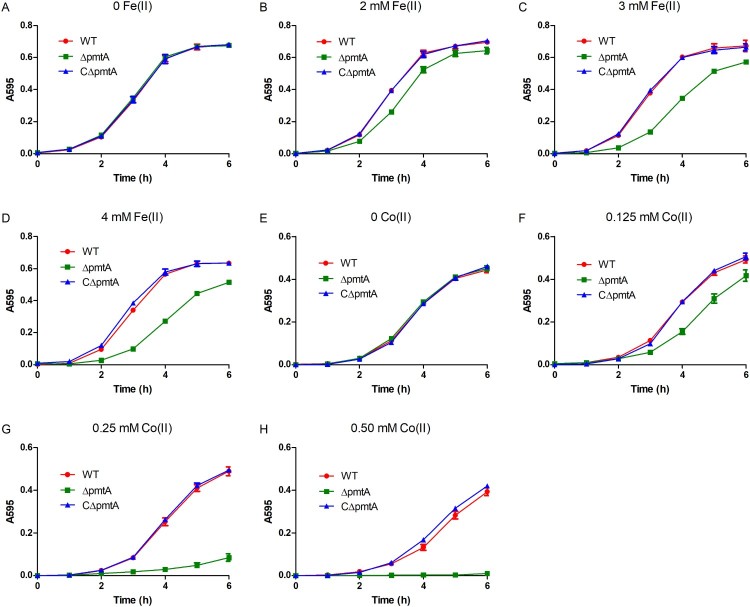
PmtA is involved in S. suis resistance to iron or cobalt excess. (A–D) The WT, ΔpmtA, and CΔpmtA strains were grown in the absence (A) and presence of 2 mM (B), 3 mM (C), or 4 mM Fe(II) (D). (E-H) Growth curves in the absence (E) and presence of 0.125 mM (F), 0.25 mM (G), or 0.50 mM Co(II) (H). Graphs data are mean values ± SD from three wells.